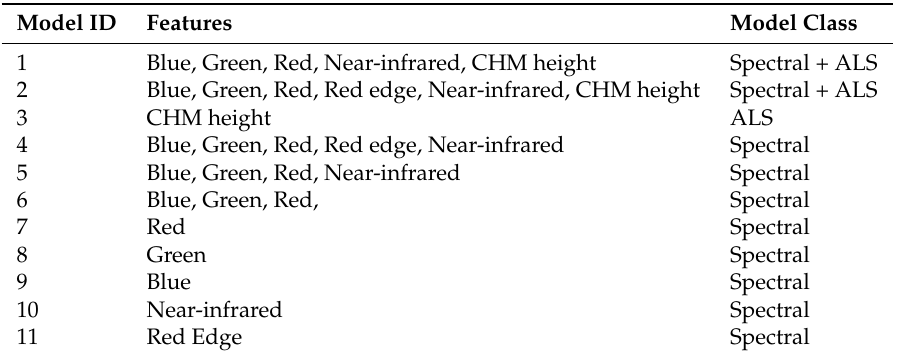
Table 1. Summary of the all models developed for selection of the best performing model of each class with model performance assessed based on cross-validation statistics from the model fitting